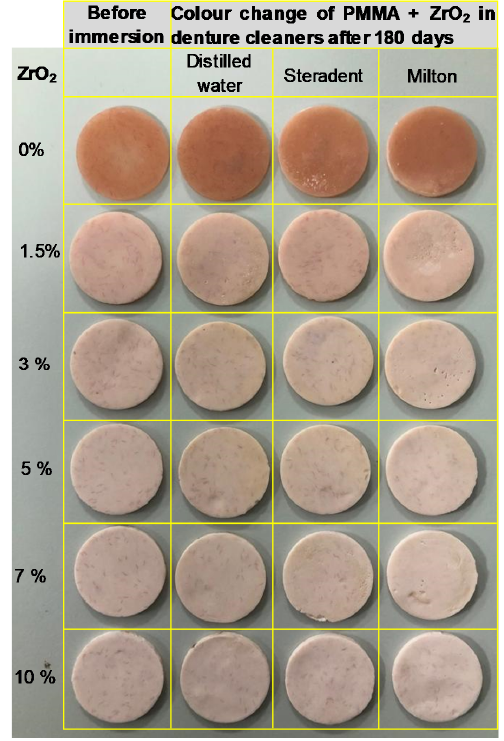
Figure 1. Photographs showing colour changes in the poly-methyl methacrylate (PMMA) + ZrO 2 samples before and after immersion in different solutions for up to 180 days.